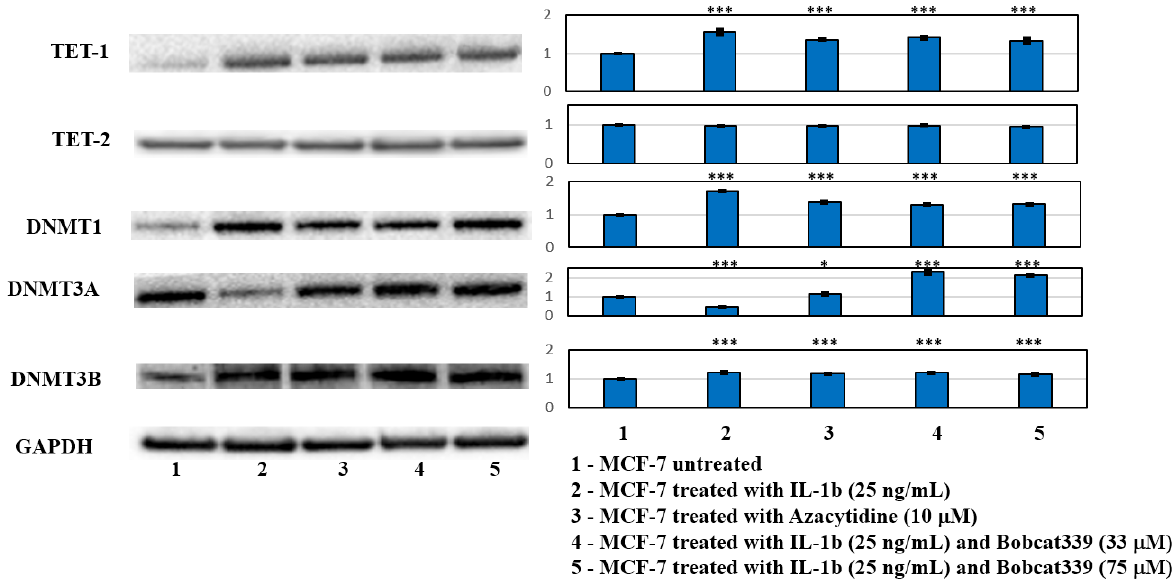
Figure 7. Western blot analysis of principal actors of DNA methylation process in MCF-7 cells un- treated and treated with IL- 1β , AZA (10 µM), and BC at the two concentrations (33 µM and 75 µM) and relative co-treatments after 48 h. Representative images of WB and densitometric analysis (Mean ± SD, n = 3) of TET-1, TET-2, DNMT1, DNMT3A, and DNMT3B. One-way ANOVA showed significant effect of treatment on densitometric data ( p < 0.0005); significant differences were high- lighted among tested treatments versus untreated MCF-7 ( p < 0.0005), except for DNMT3A between AZA and untreated MCF-7 ( p < 0.05). Furthermore, significant differences were found among IL- 1β /BC co-treatments versus the IL- 1β one ( p < 0.0005), except for DBNT3B in IL- 1β /Bobcat339 (33 µM) treatment. One-way ANOVA showed significant effect of treatment on densitometric data; sig- nificant differences among tested treatments versus untreated MCF - 7 (*) are reported in the graphs (*, p < 0.05; ***, p < 0.0005). 3. Discussion IL- 1β is the principal inflammatory cytokine induced and activated following infec- tions or tissue damage. High levels of IL-1 β in the tumor microenvironment are associated with high proliferation and aggressive phenotype [2]. IL-1 β is able to induce the progres- sion of breast cancer from a benign to a malignant stage, resulting in the deregulation of several growth factors, cytokines, and chemokines [24]. However, the mechanisms under- lying these deregulated processes are still poorly understood. Data obtained from this study demonstrated that IL-1 β had the capacity to induce changes in gene expression, and modulate genome DNA methylation status, resulting in it being a prerequisite for tumor progression and bone metastasis. This modulation seems tightly related to the DNA de-methylation of the MCF-7 cell line genome, indicated by a reduction in methyl-cytosine and an increase in hydroxy-methyl-cytosine genomic con- tents, similarly to the AZA treatment (Figure 1B). AZA is a de-methylation agent that binds DNMT enzymes, blocking their activities, and in some tumors is indicated as a chemotherapeutic agent. Nevertheless, AZA is suspected to induce metastasis [25,26] through the same general de-methylation that sensitizes it to apoptosis [27]. We hypothe- sized that Bobcat339, acting epigenetically against de-methylation (Figure 1B), blocked IL- 1 β -dependent epigenetic actions, interfering with EMT and bone metastasis. The MTT assay showed IL-1 β induced an increased proliferation of the MCF-7 cell line, unlike the AZA and Bobcat treatments. Interestingly, only the co-treatment with Bob- cat, and not with AZA, was able to revert IL-1 β -induced proliferation, indicating that this action was partially related to TET activity blocked by Bobcat339. Furthermore, the